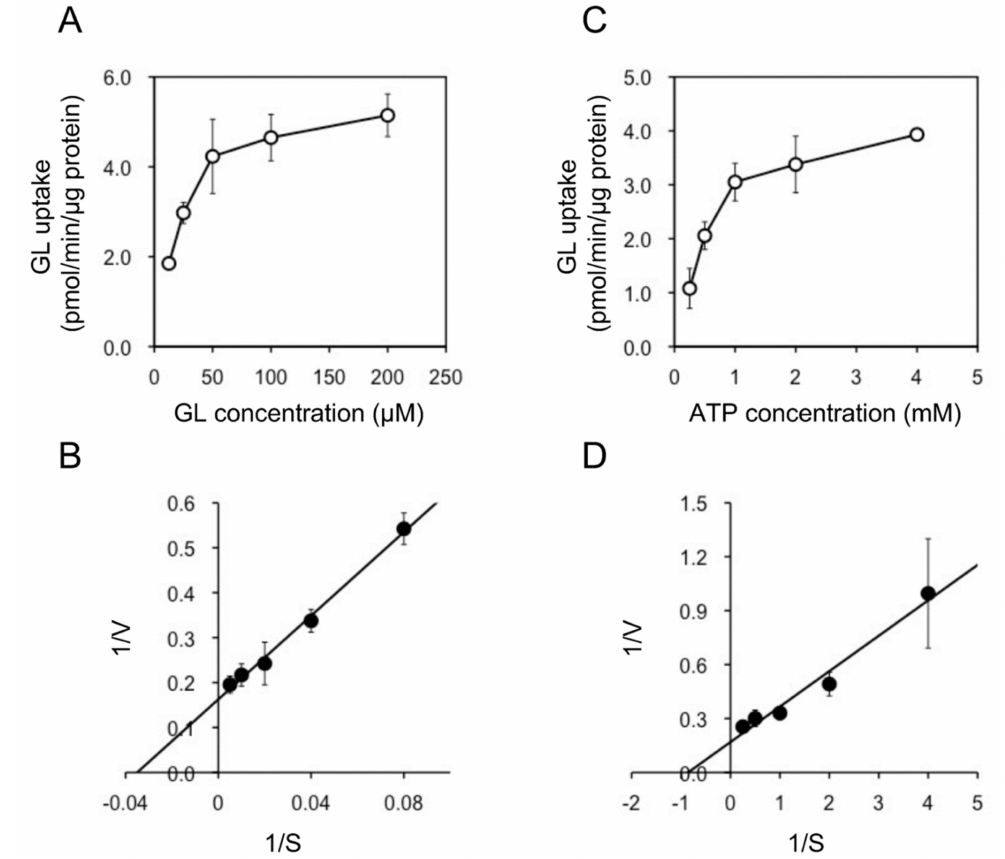
Figure 8. Kinetic analysis of ATP-dependent GL transport by tonoplast vesicles. ( A ) Tonoplast vesicles were incubated with various concentrations of GL in the presence of 5 mM MgATP. ( B ) Lineweaver– Burk plot of the concentration dependence of GL transport. ( C ) Tonoplast vesicles were incubated with 100 µ M GL and various concentrations of MgATP. ( D ) Lineweaver–Burk plot of ATP-dependent GL transport. Data are presented as the mean ± standard deviation from triplicate